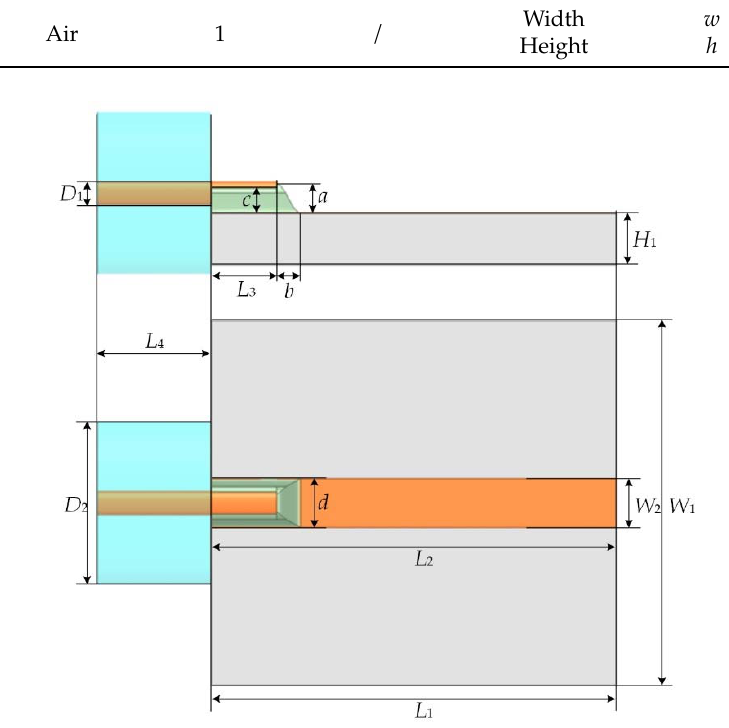
Figure A1. Lead wire interconnection.